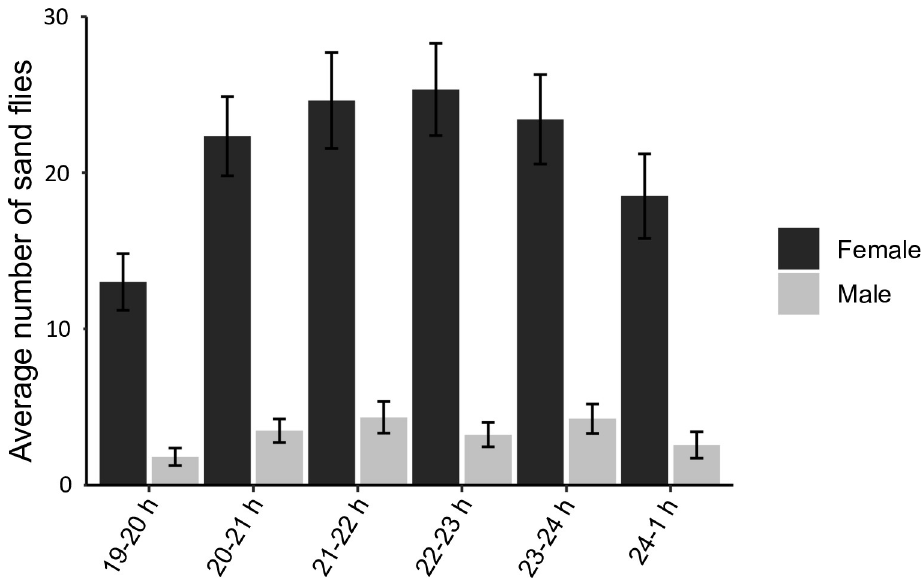
Fig 5. Phlebotomus pedifer activity pattern based on CDC light trap captures. The left, dark grey and the right, light grey bars are respectively the average number of female and male sand flies at a certain time interval. Error bars represent the standard error of the response